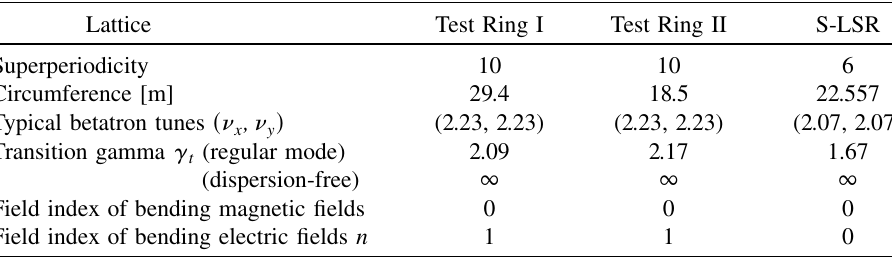
TABLE I. Main lattice parameters considered in simulations.